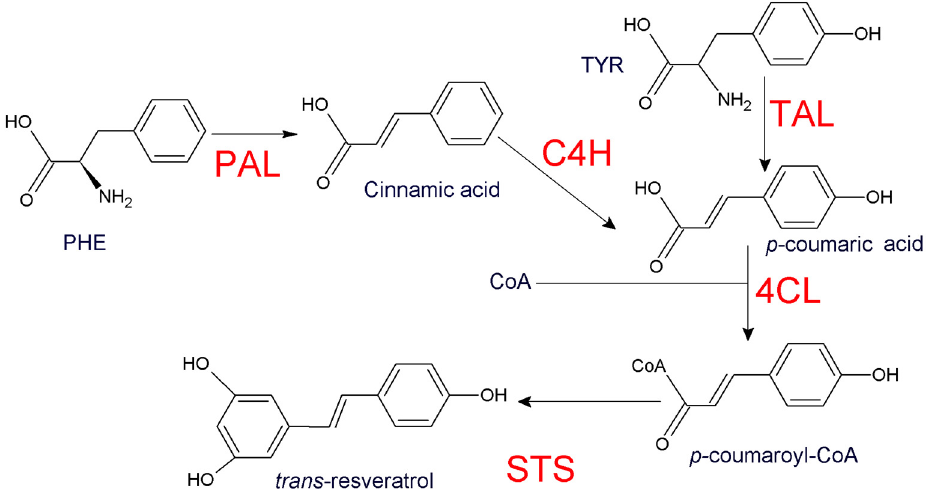
Figure 1. Biosynthesis of resveratrol in higher plants. Keys enzymes are highlighted in red. Phenylalanine ammonia lyase (PAL), tyrosine ammonia lyase (TAL), cinnamate 4 hydroxylase (C4H), p -coumaric-acid coenzyme A ligase (4CL) and stilbene synthases (STS).